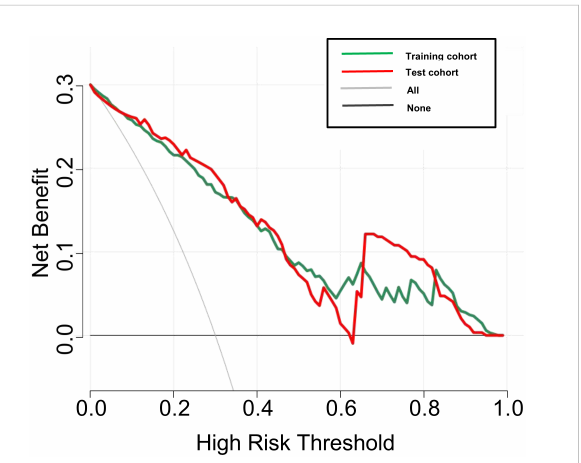
FIGURE 4 Calibration curves for the DLCT-based nomogram in the training and test cohort. The 45°straight line indicates the ideal performance of the DLCT-based nomogram. A closer distance between two curves indicates higher accuracy.